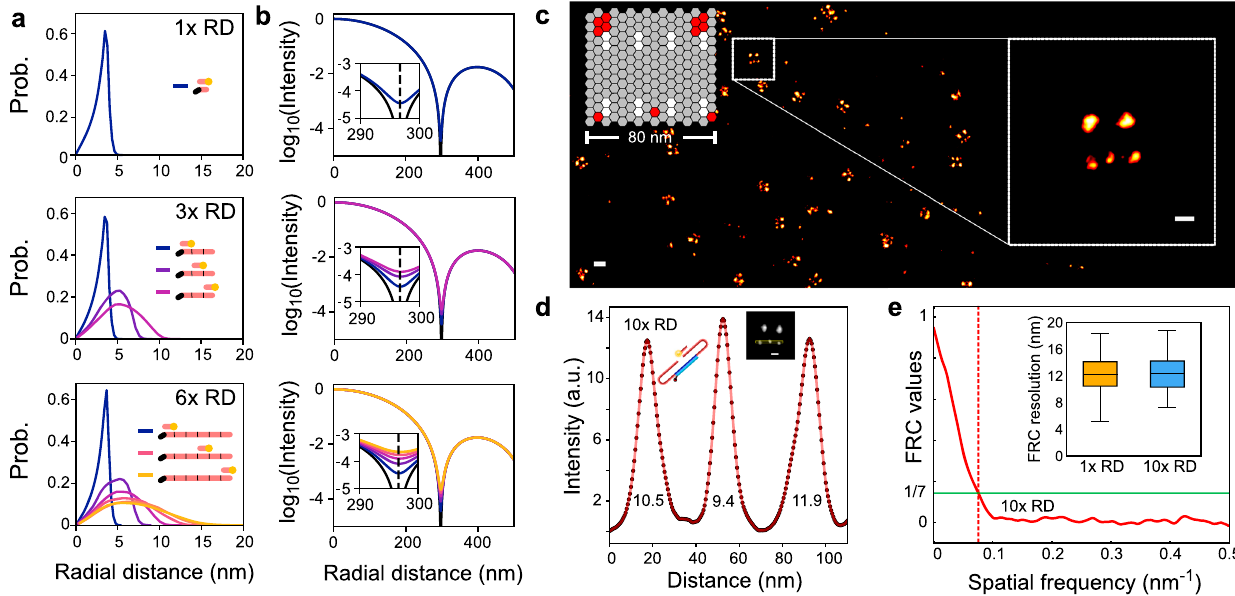
Fig. 5 Repeat DNA-PAINT preserves spatial resolution. a Simulated radial distributions of the fl uorophore site on imagers hybridized to all possible sites on 1x RD, 3x RD, and 6x RD, with respect to the anchoring point of the docking motif. b Radial pro fi les of blinks as obtained by convolving the fl uorophore- distributions with the microscope point-spread function (Supplementary Fig. 6). Insets: zoom in of the region around the fi rst Airy minimum, showing very small broadening that is unlikely to be experimentally detectable. c Scheme of DNA-origami test tiles with red sites indicating the locations of 10x RD motifs and a rendered DNA-PAINT image, similar origami quality observed in n = 7 origami experiments. d Typical spatial pro fi les measured across the ‘ spots ’ of origami tiles with 10x RD strands as in c , with full-width at half maximum (FWHM) spot diameters as indicated. The average FWHM is 12.28 ± 1.77 nm (mean ± SD), nearly identical to 12.56± 2.09 nm determined for 1x RD (Supplementary Fig. 7). e Fourier Ring Correlation (FRC) resolution measurements of DNA-PAINT images of origami tiles with 1x RD strands (12.12 ± 2.69 nm, mean ± SD) are indistinguishable from 10x RD (12.36 ± 2.67 nm). Boxplots show minima, maxima and median of the data. Scale bars: 30 ~2.2% (Fig. 4b, c), a 5-fold suppression. Direct examination of the histograms describing the distribution of detectable sites per tile show that with 1x RD more than 50% of the initially complete tiles lost at least one site (Fig. 4b). In turn, the vast majority of Fig. 5a, demonstrate narrow fl uorophore distributions for the complete DNA origami tiles remained intact when using 10x RD docking strands (Fig. 4c).